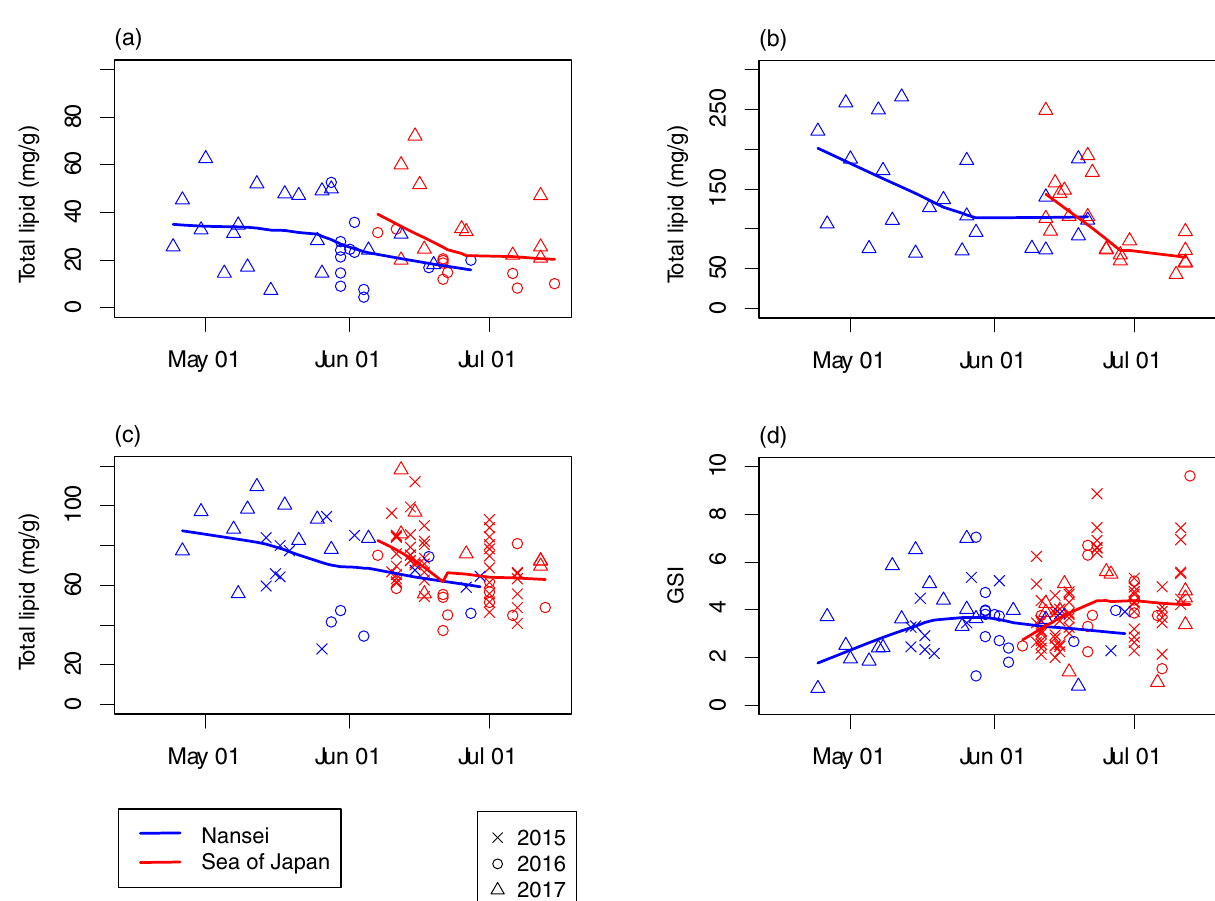
Fig 3. Seasonal change in total lipid in muscle (a), liver (b) tissues, and oocytes (stage Ly) from within the ovary (c), and GSI (d) of female Pacific bluefin tuna around the Nansei Islands (blue) and Sea of Japan (red) in 2015 (crosses), 2016 (open circles), and 2017 (open triangles); with Lowess smoothing curves (bandwidth,